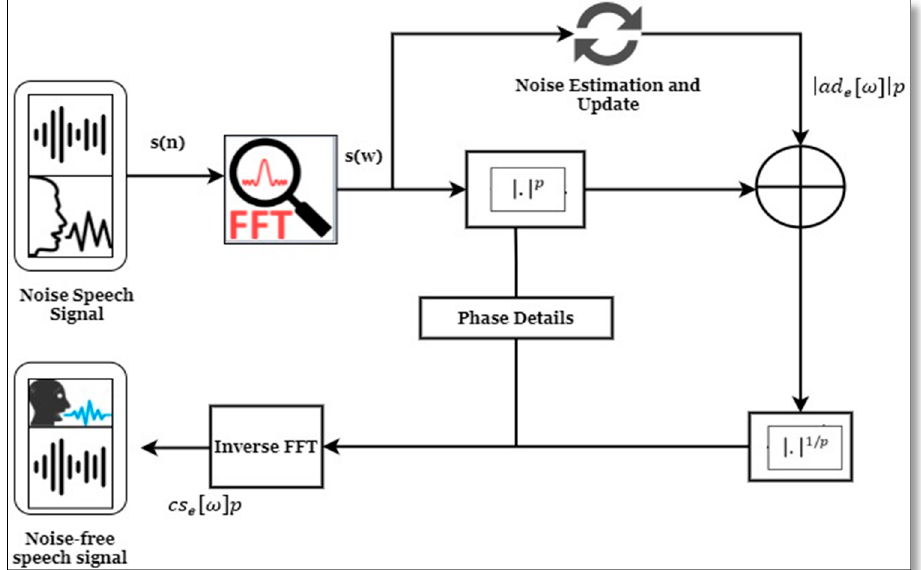
Figure 2. Speech signal noise removal using spectral deduction method.